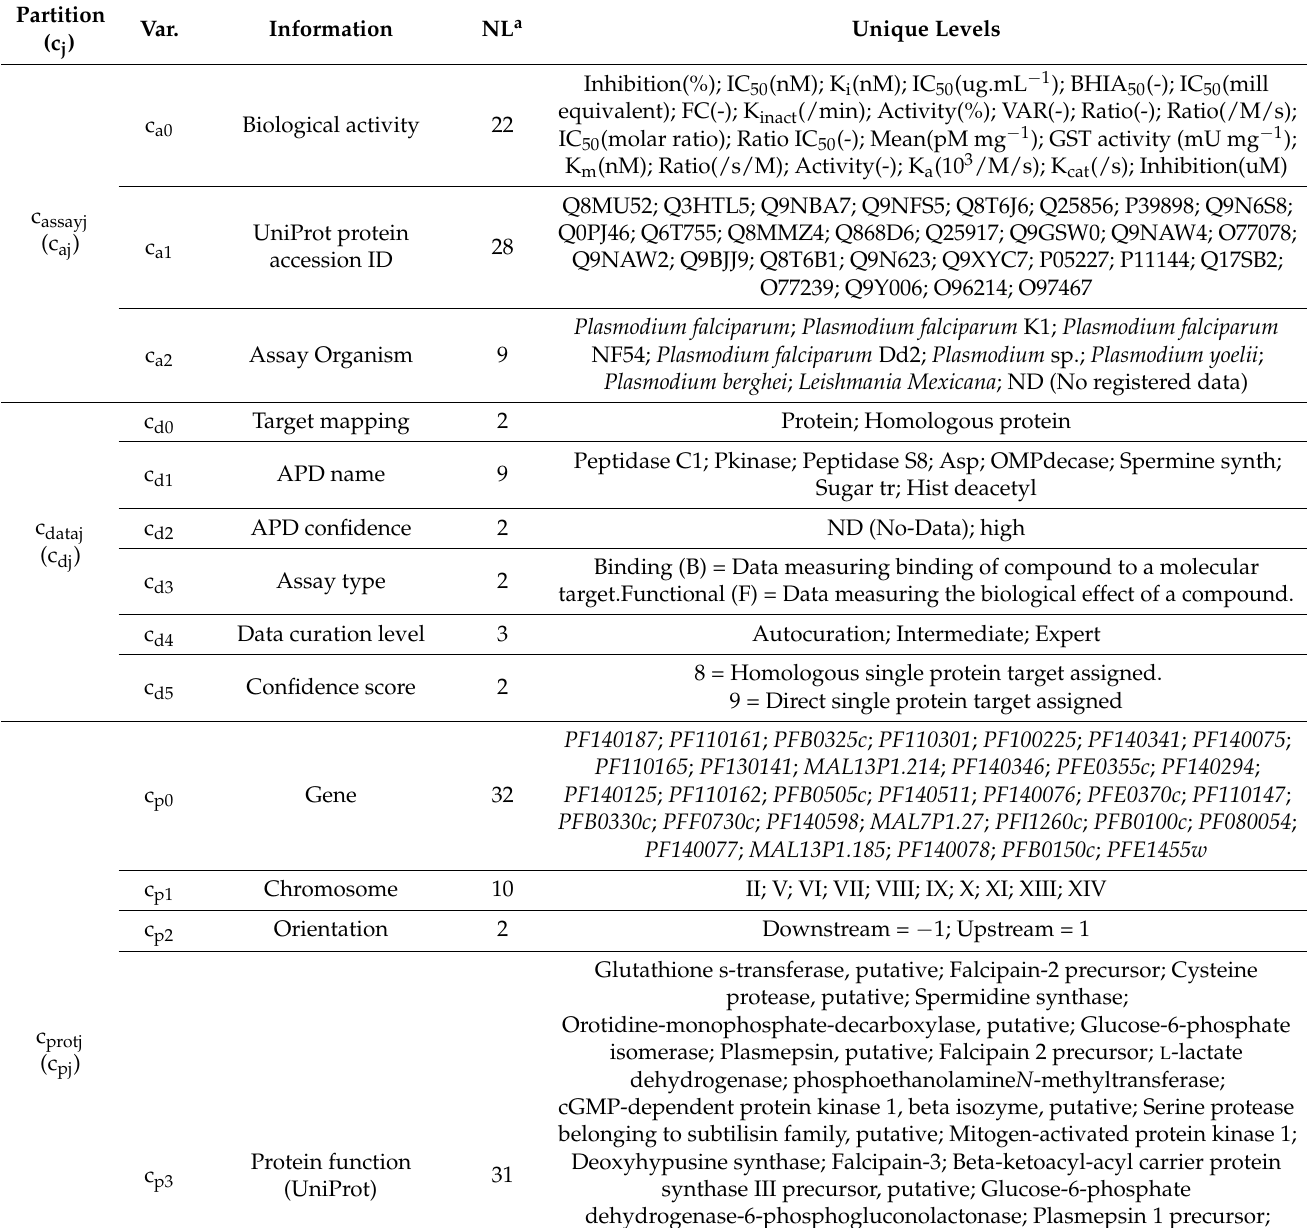
Table 7. Partitions and levels (unique values) taken by the categorical (not ordered) input